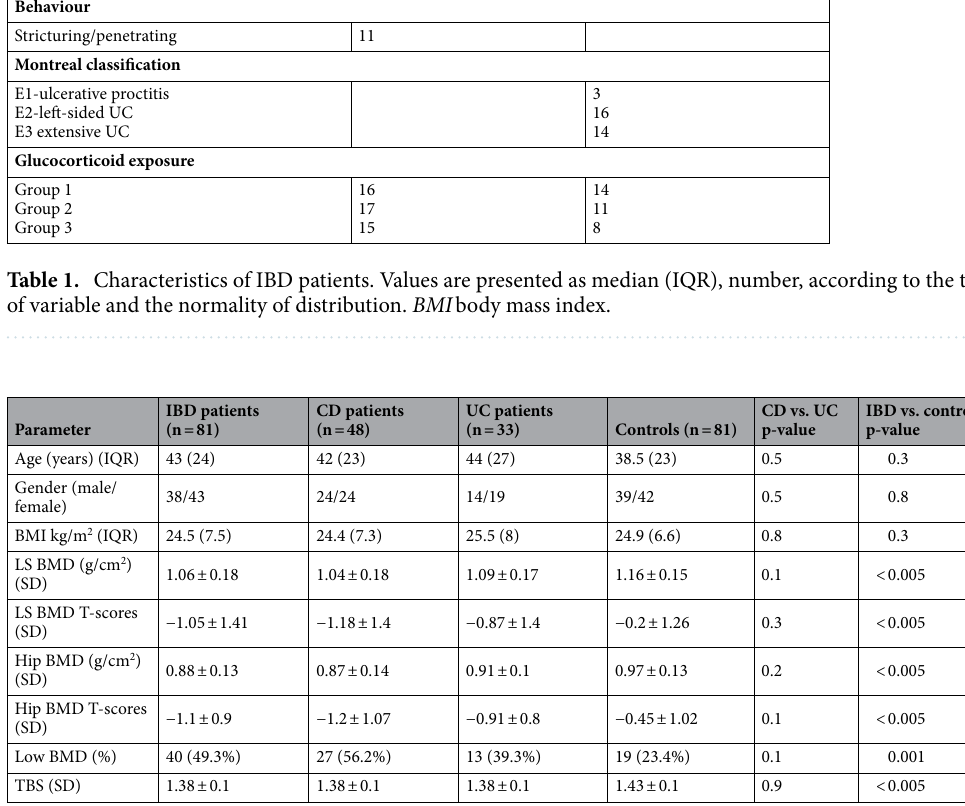
the patients were categorised in group 1, 28 patients in group 2 and 23 patients in group 3. Disease characteristics of the patients are presented in Table 1. DXA parameters. Differences in DXA parameters between IBD patients and healthy controls. 81 control subjects were included in the study, 42 women and 39 men, with a median age 38.5 (23) years and a median BMI of 24.9 (6.6) kg/m 2 . Compared with the controls, the IBD patients had significantly lower LS BMD (1.06 ± 0.18